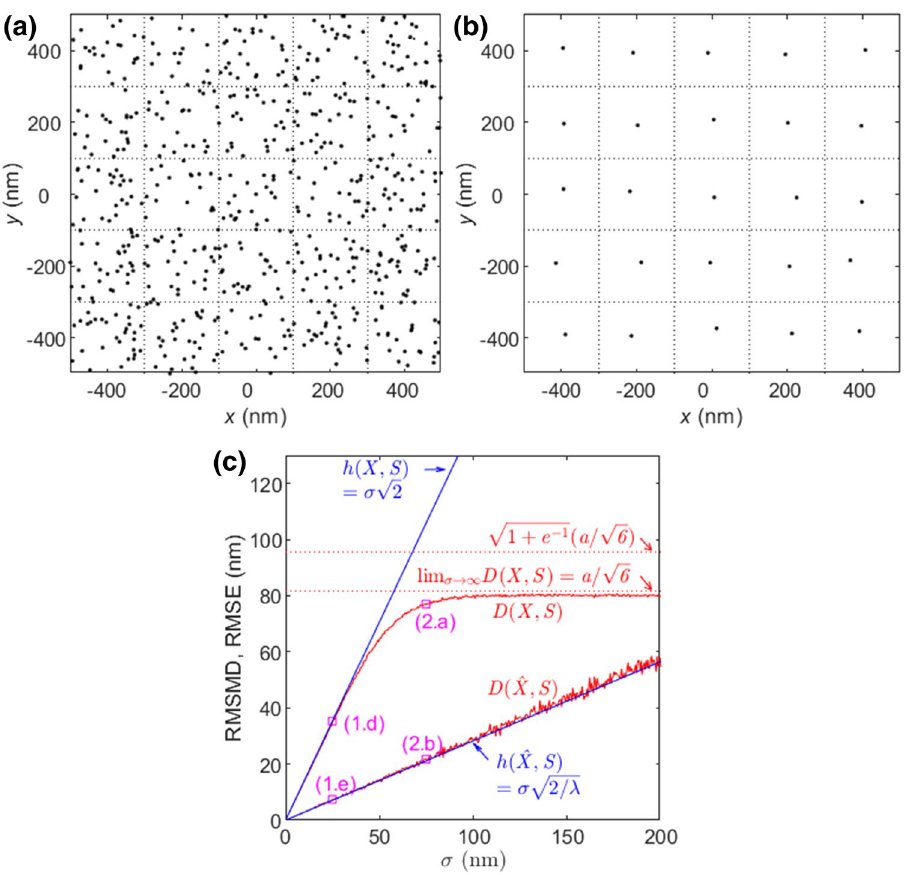
25 . ( a ) X with = X versus σ . The ˆ